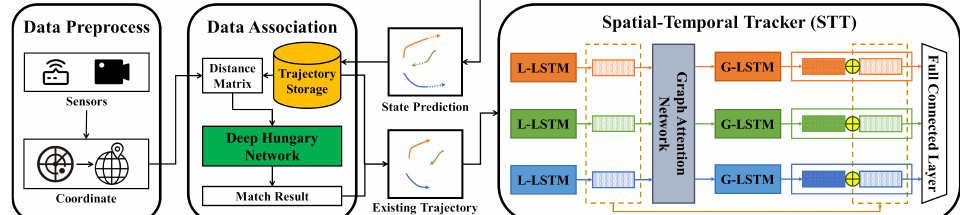
Figure 3. Overview of the proposed